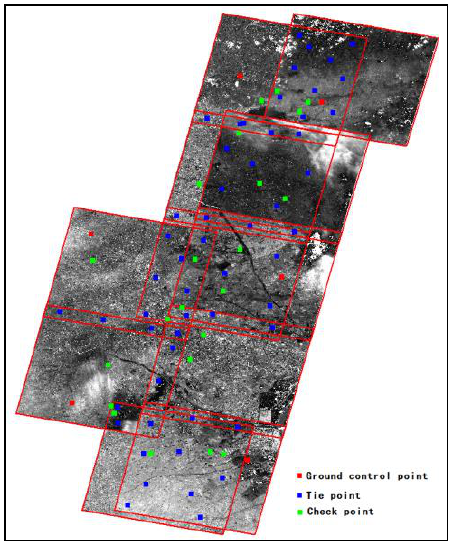
Figure 5. GCP and Tie point distribution